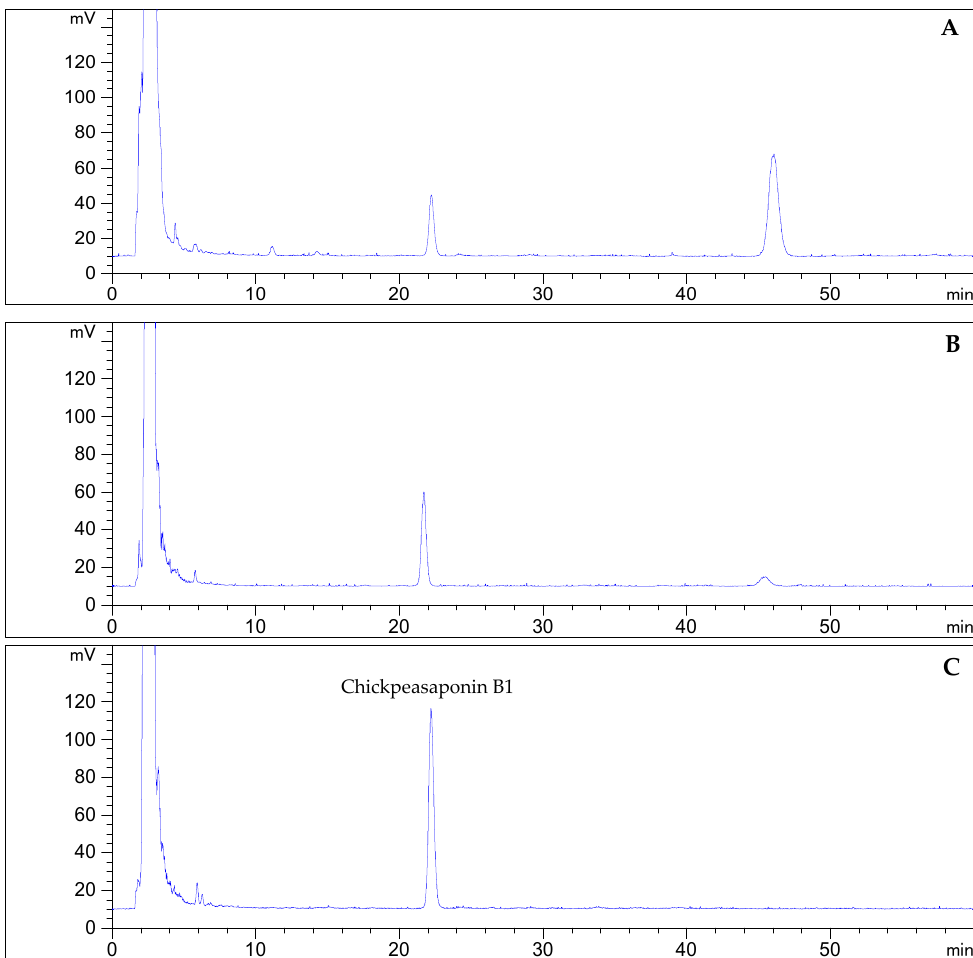
Figure 6. Quantification by HPLC-ELSD of chickpeasaponin B1 obtained from chickpea extracted by MAE ( A ); the total saponins degraded by potassium hydroxide in 75% aqueous ethanol (1%, g/mL) for 0.5 h ( B ); and 12 h ( C ).